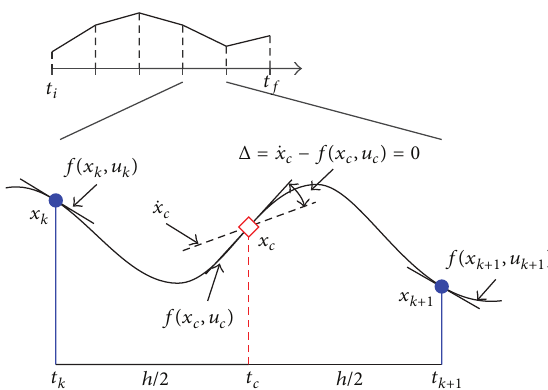
Figure 1: Hermite-Simpson collocation